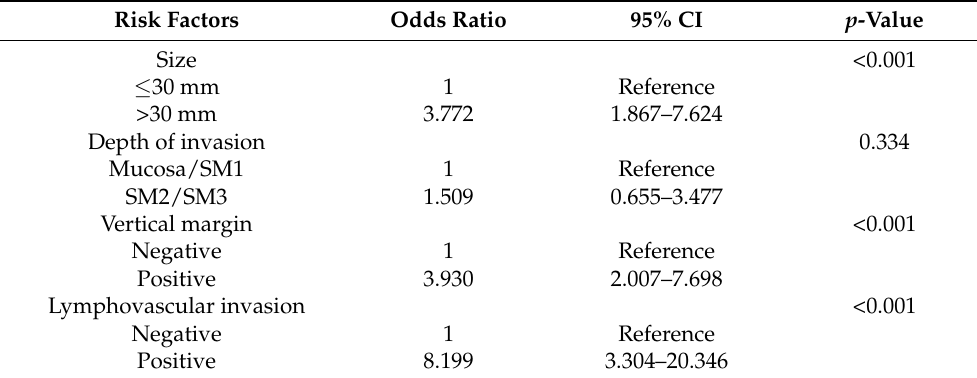
Table 3. Multivariate risk factor analysis for lymph node